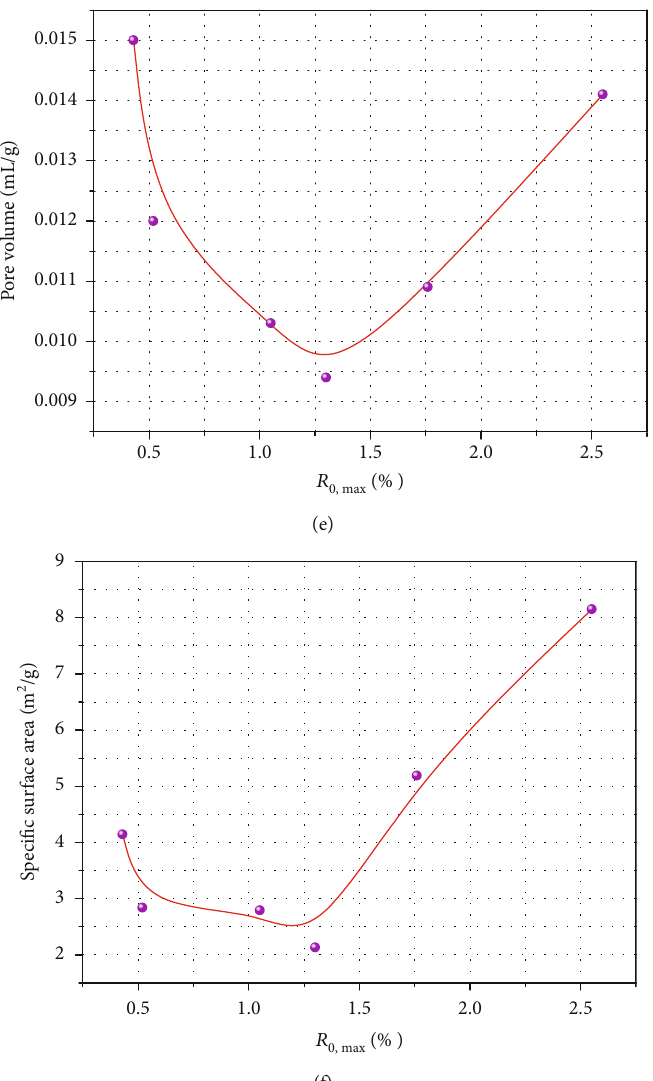
Figure 8: Results of the low-temperature nitrogen adsorption experiment. (a) Pore volume distribution; (b) pore volume proportion; (c) pore speci fi c surface area distribution; (d) pore speci fi c surface area proportion; (e) shows the relationship between total pore volume and metamorphic degree; (f) shows the relationship between total speci fi c surface area and metamorphic